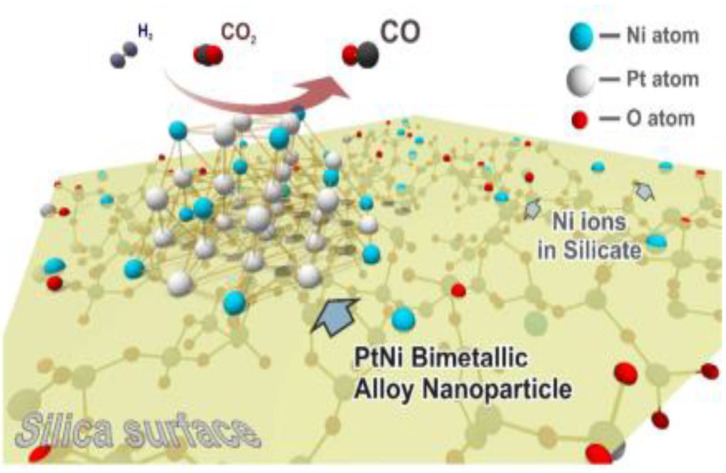
Schematic model of the PtNi/SBA-15 catalyst. Reprinted with permission from Liu et al. (2018). Copyright (2018) American Chemical Society.